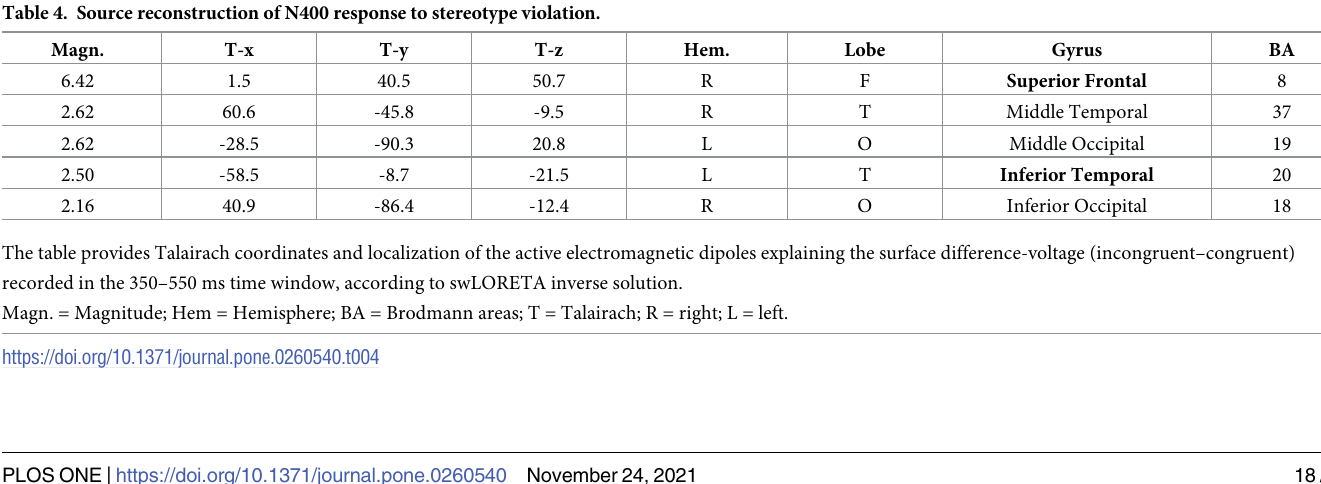
PLOS ONE | https://doi.org/10.1371/journal.pone.0260540 November24,